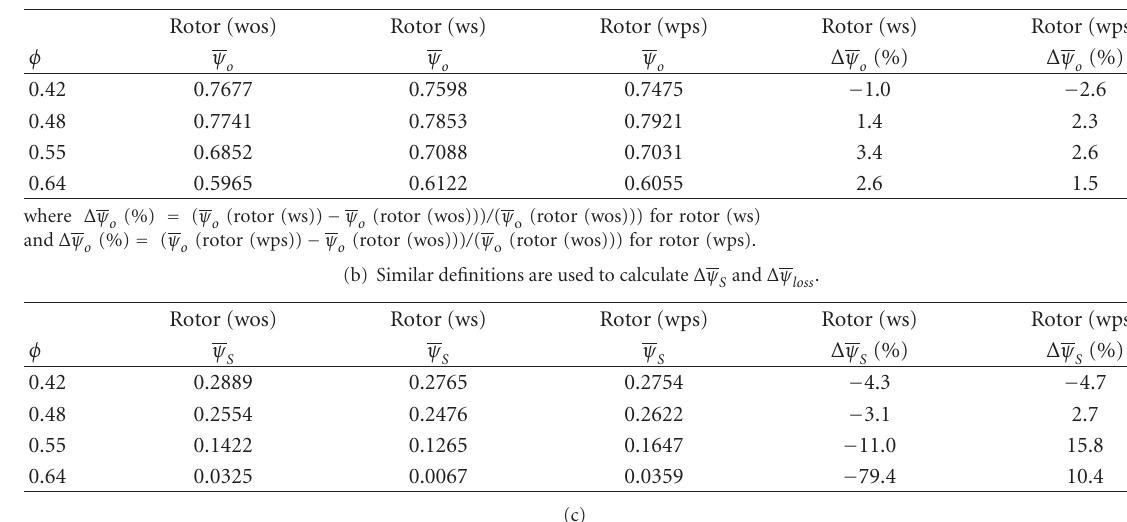
Table 5: Comparison of mass averaged values.